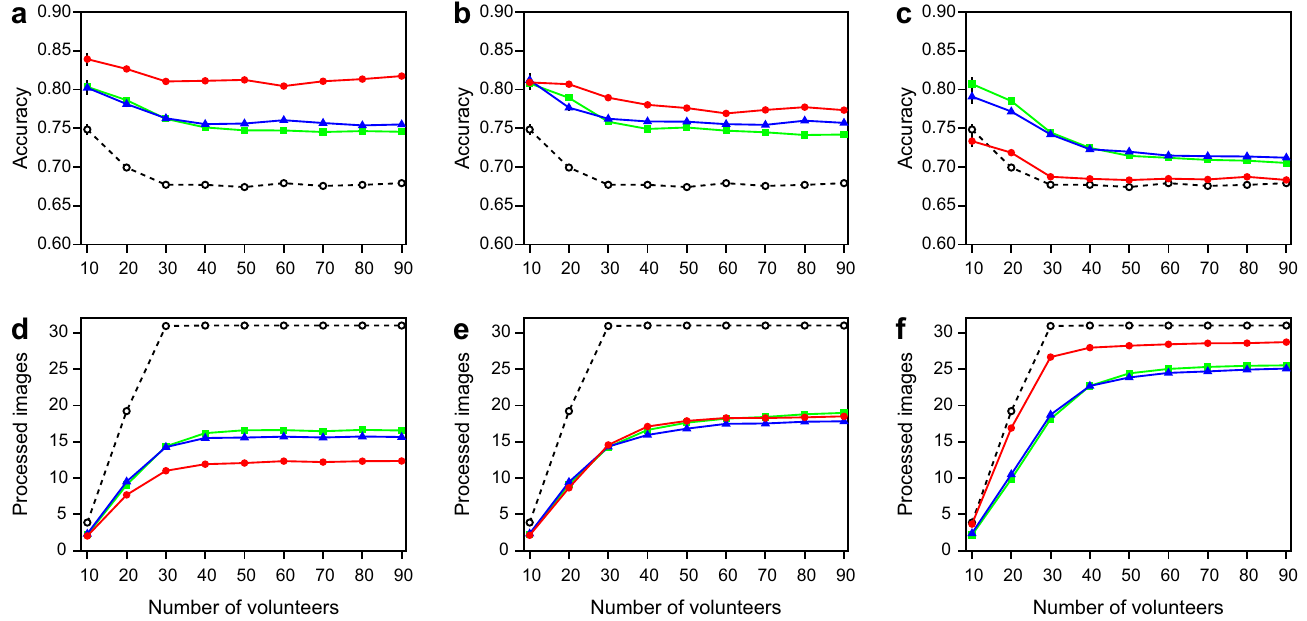
Fig 3. Performance of image classification over different numbers of volunteers. (a) Accuracy at entropy threshold 0.2, (b) at 0.5, and (c) at 0.8. (d) The number of processed images at entropy threshold 0.2, (e) at 0.5, and (f) at 0.8. Colors correspond to Fig 2 (square: case 1, filled circle: case 2, triangle: case 3, open circle: no entropy